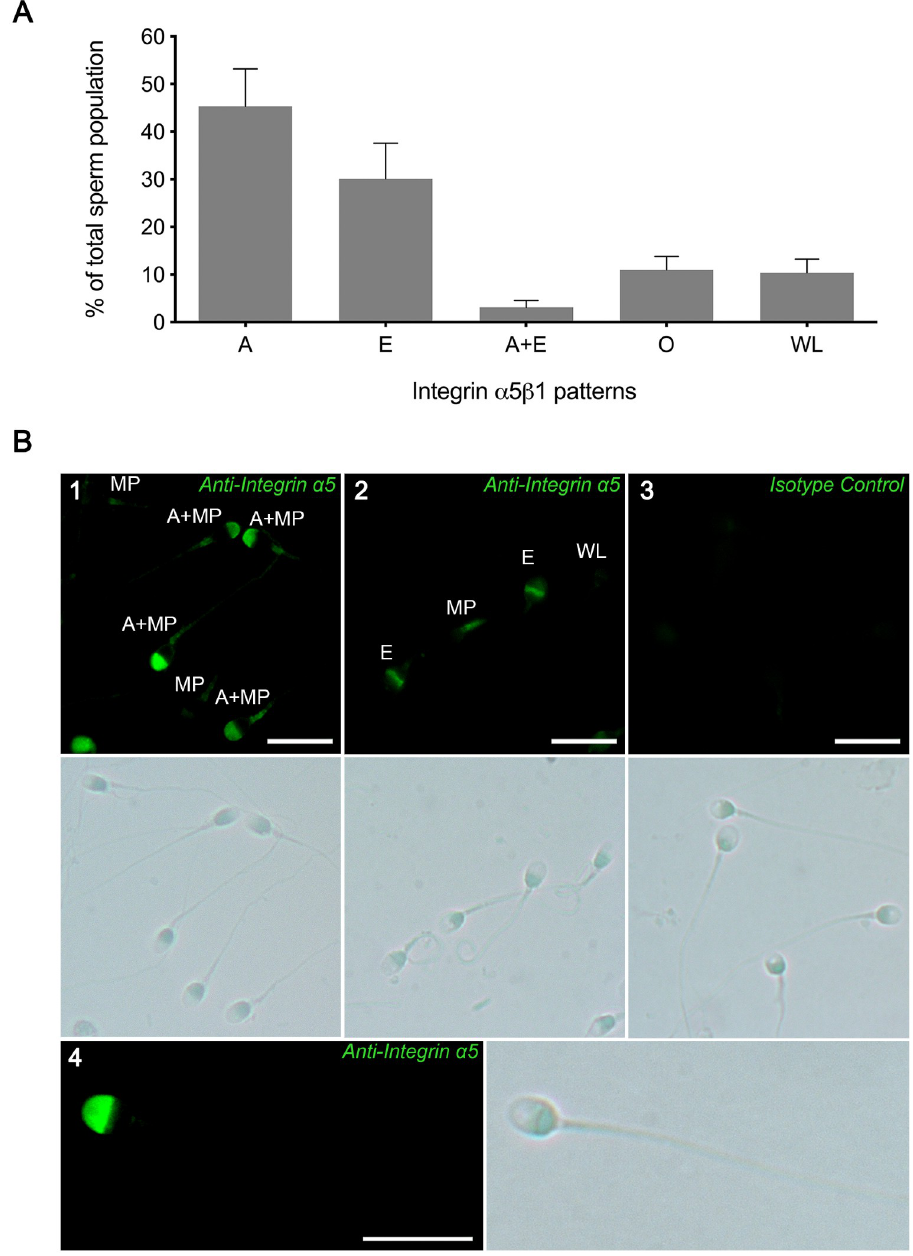
Fig 1. Integrin α 5 β 1 localization in human sperm. Sperm were fixed and the integrin α 5 β 1 was detected by immunofluorescence. A) Incidence of integrin α 5 β 1 different patterns. The population was quantified according to α 5 β 1 localization patterns: acrosomal region (A), equatorial segment (E), acrosomal and equatorial segment(A+E), other patterns(O) and without label(WL). Bars indicate the percentage of classified sperm of total population. Results are shown as mean ± SEM. n = 27. B) Subcellular localization of integrin α 5 β 1 in human freshly ejaculated sperm. Letters indicate the different patterns of integrin α 5 β 1 localization. Panel 1: A + midpiece (MP) and MP. Panel 2: E, MP and WL. Panel 3: Isotype control. Panel 4: Single sperm zoom-in displaying integrin α 5 β 1 with the A pattern. The images are representative of at least 27 sperm samples; Bar scale: 10 μ m; M:1000x.